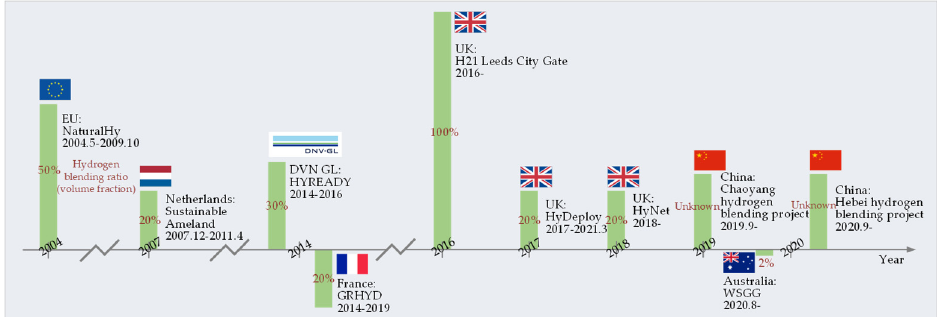
Figure 1. Status of HCNG-related projects worldwide.